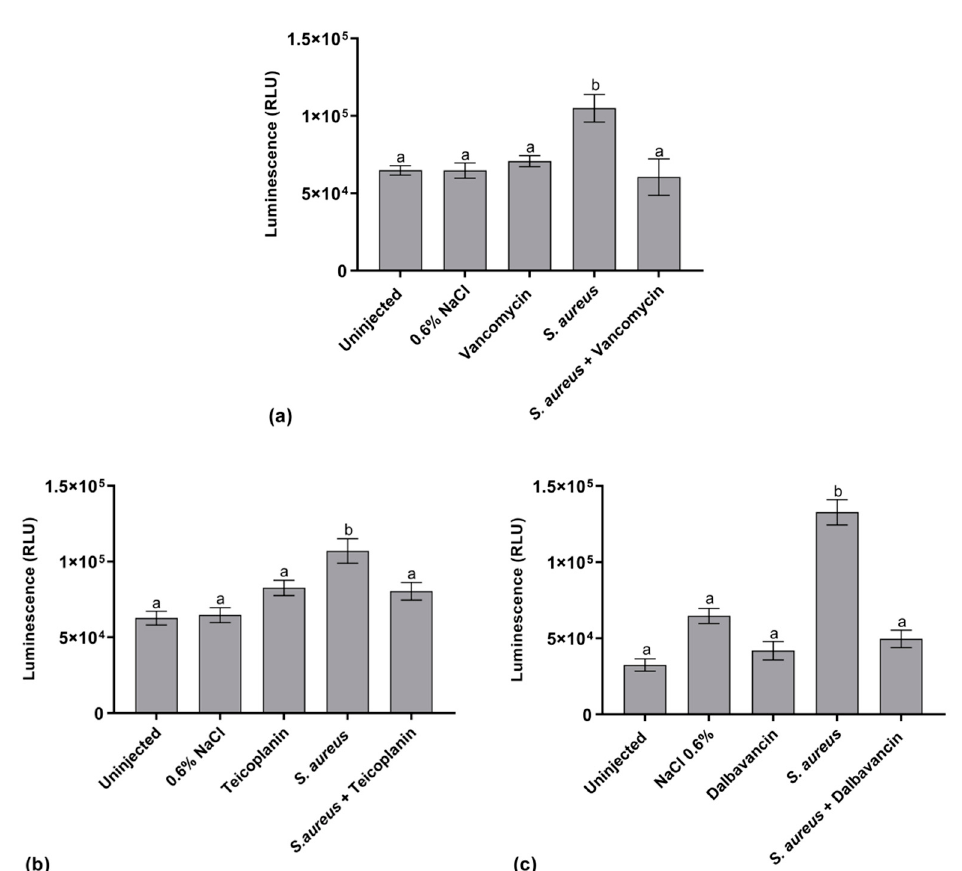
Figure 5. Luminescence indicating hemocyte activity in control larvae (uninjected larvae and larvae injected only with physiological solution) and in healthy and infected larvae treated and untreated with vancomycin ( a ), teicoplanin ( b ), and dalbavancin ( c ) at 8.75 μ g/g body weight. Values represent mean ± s.e.m. Different letters indicate statistically significant differences among treatments ( p < 0.05).